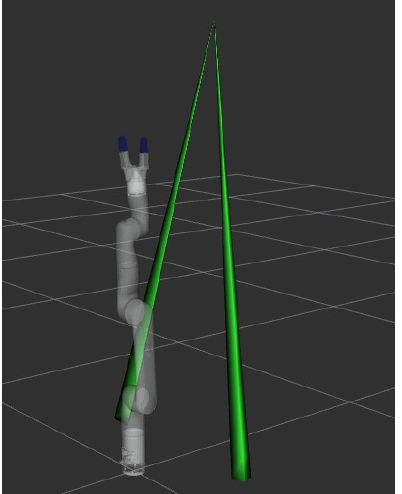
Figure 8. Virtual obstacles in Rviz representing the line of sight between two objects and the camera of example no. 2, Section 8.1 (the third cone between the camera and the object to be picked is not